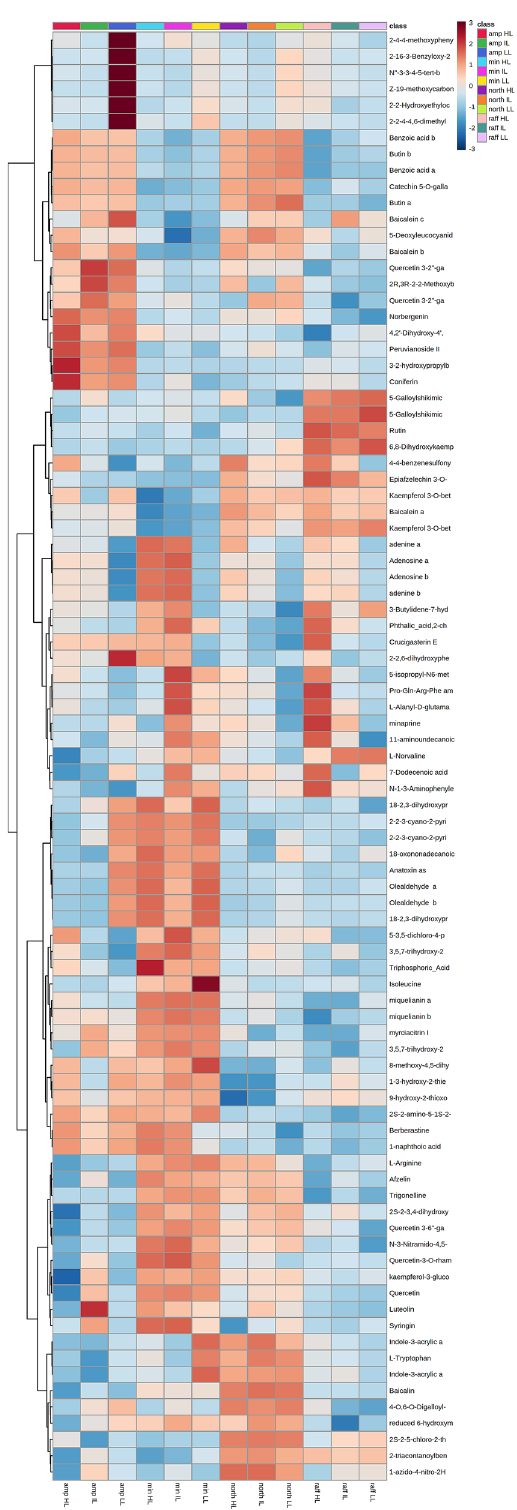
Figure 3. Heatmap of 89 identified metabolites from the 4 Nepenthes species based on Euclidean distances and Ward clustering. The metabolites concentrations are represented on a log scale. A more detailed bar chart of the important metabolites is provided in the Supplementary Fig.